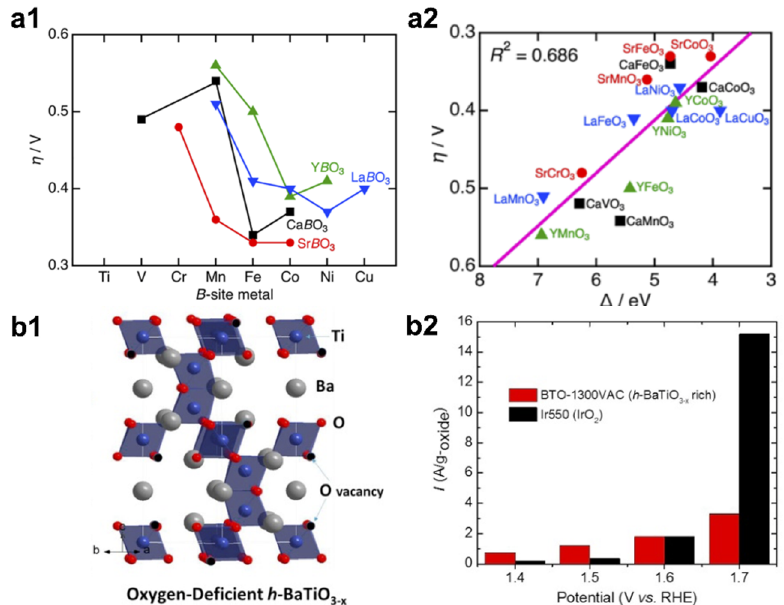
Figure 9. ( a ) Systematic comparison of various first d-block metal-based perovskite oxides used for the OER: ( a1 ) A comparison of the OER overpotential and ( a2 ) the OER overpotential as a function of the charge transfer energy; reproduced with permission [113] Copyright (2014),: American Chemical Society. Oxygen-deficient BaTiO 3– δ as a highly-active OER electrocatalyst: ( b1 ) A structural illustration of BaTiO 3- δ and ( b2 ) a comparison of the OER mass activity between BaTiO 3- δ and Ir550; reproduced with permission [114] Copyright (2015), Elsevier.